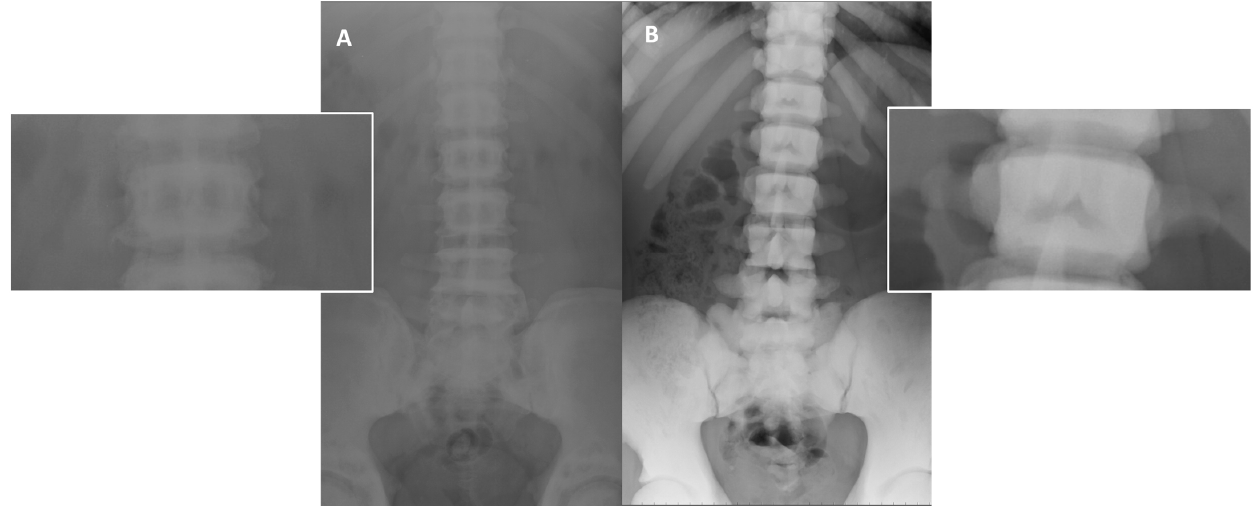
Figure 8. Different pattern of bone sclerosis in different type of osteopetrosis. Conventional radiographies (AP projection) in osteopetrosis ADO type 2 ( A ) and ARO ( B ) show different type of abnormally increased bone density: well-defined sclerosis of vertebral endplate (‘rugger jersey spine’—( A )) in ADO type 2, and complete and marked sclerosis of the whole vertebrae in ARO type ( B